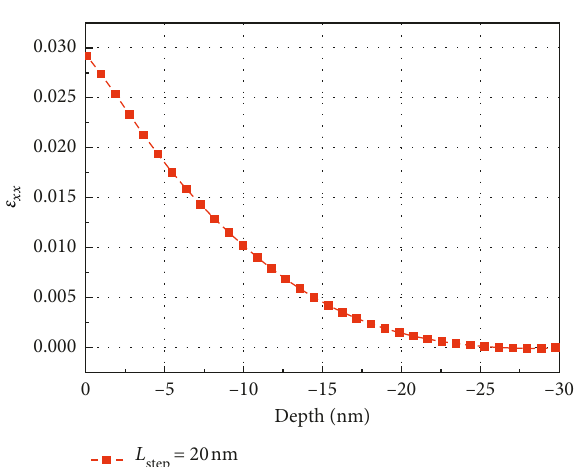
Figure 16: Vertical change diagram of ε